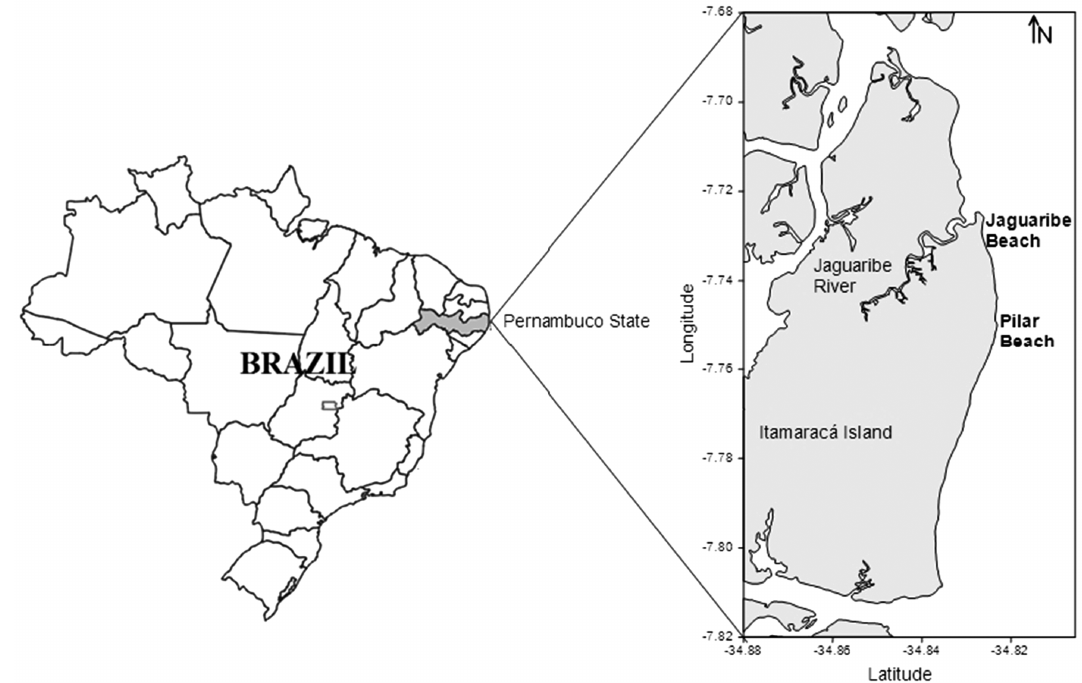
Figure 1. Study area – Jaguaribe and Pilar sites, Itamaracá Island, Pernambuco, Brazil.